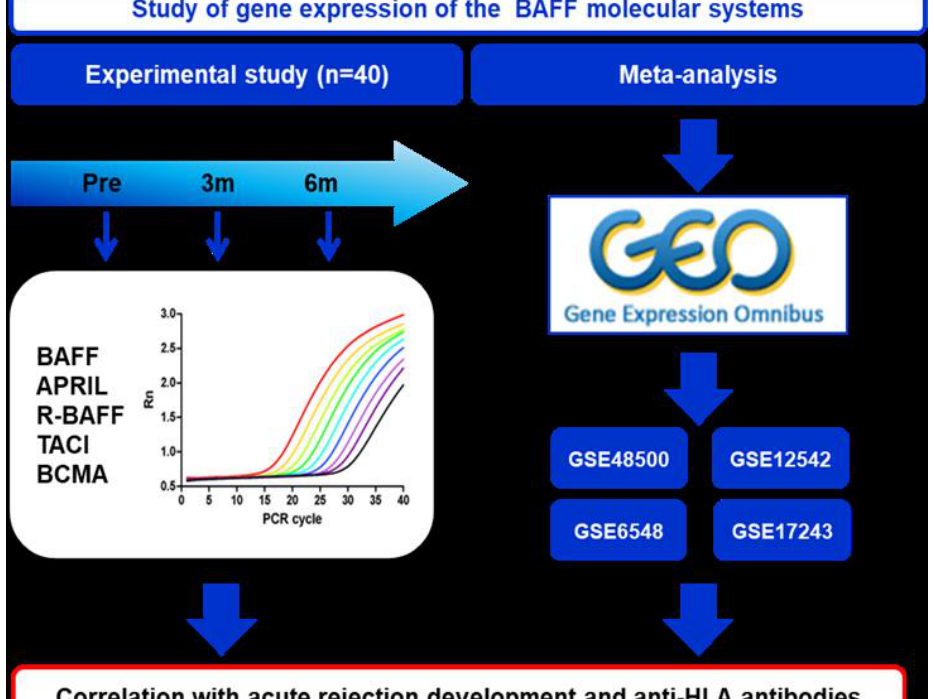
Figure 1. Design of gene expression study of BAFF system molecules in kidney recipients. AFF, B-cell activating factor; APRIL, Proliferation-inducing ligand; R-BAFF, B-cell activating factor receptor; TACI, transmembrane activator and calcium modulator interactor; BCMA, B-cell maturation antigen.